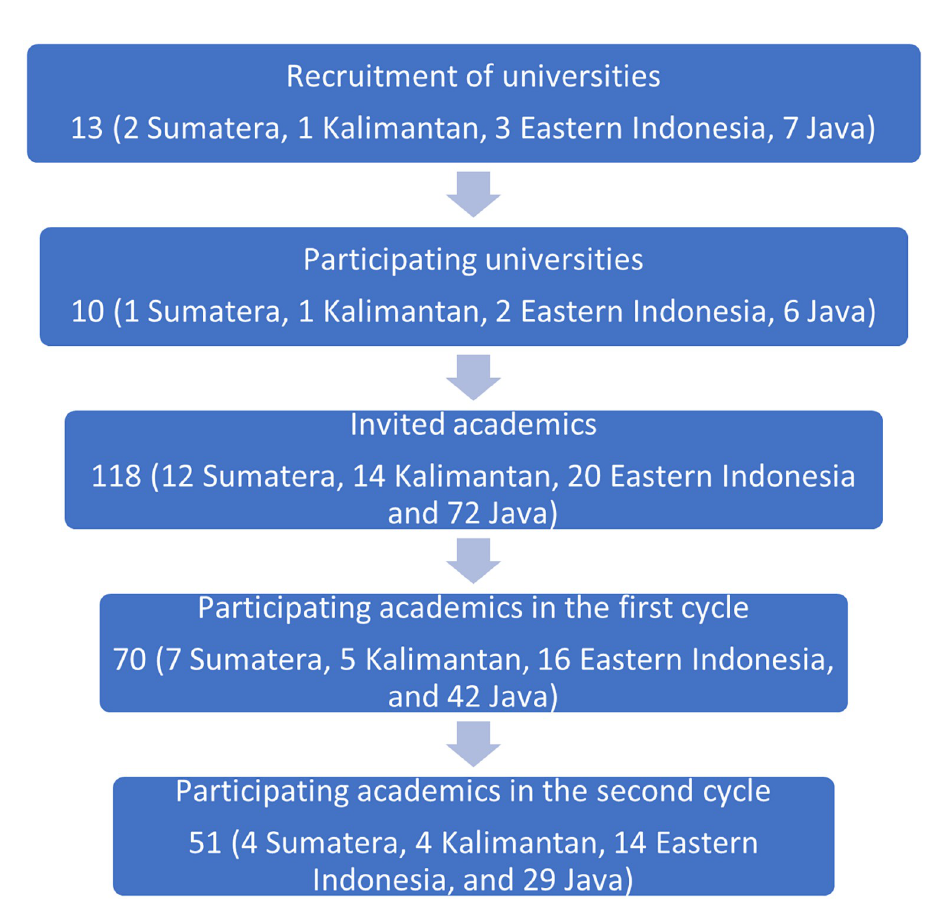
Fig 1. The recruitment process for the modified Delphi